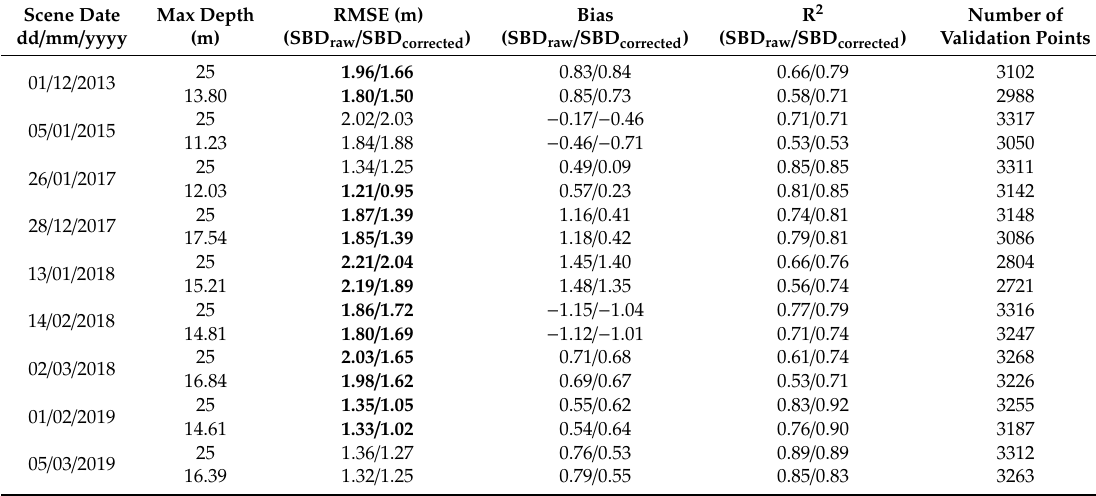
Table 4. Summary validation statistics for satellite-derived bathymetry (SDB) estimates (SDB raw and SDB corrected ) for the two depth limits in this study. Bold letters in the root-mean-squared-error (RMSE) column indicate where an observed di ff erence between SDB raw and SDB corrected estimates is more than 0.1